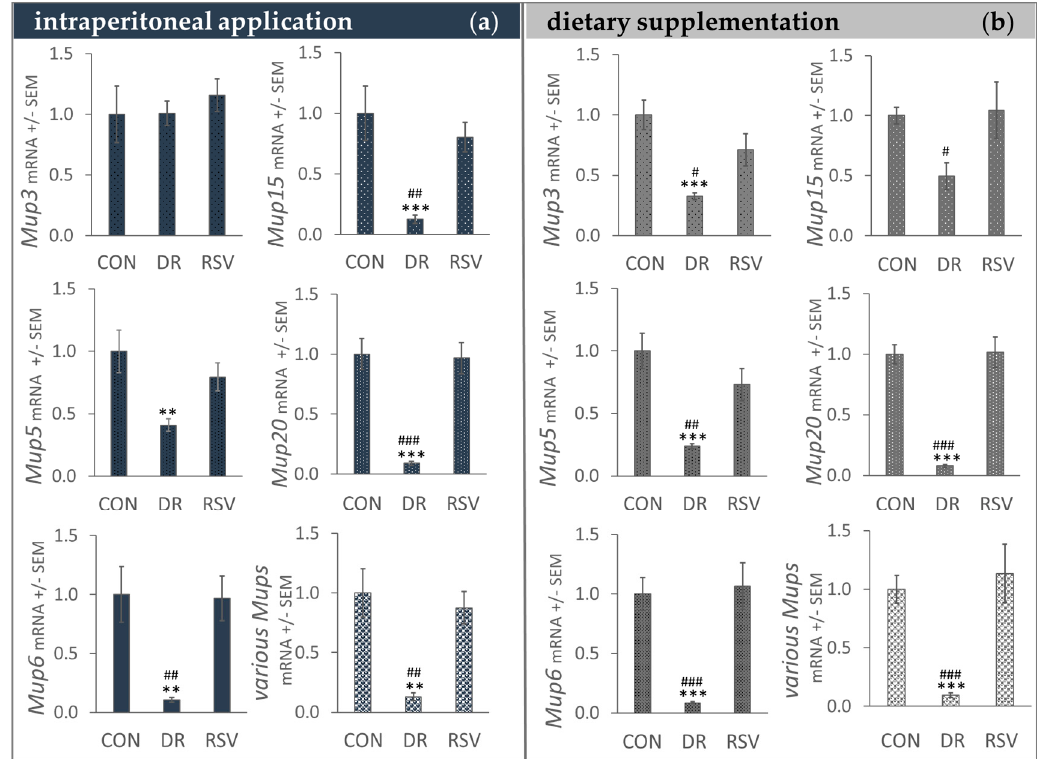
Figure 2. Real-time RT PCR results for gene coding for mouse urinary protein ( Mup ) mRNA levels in livers of mice injected intraperitoneally ( a ) or fed ( b ) with resveratrol (RSV) compared to ad-libitum control mice (CON) and mice under dietary restriction (DR). mRNA levels were normalized to 18S ribosomal RNA and related to CON which was set to be 1. Data is shown as means +/ − SEM. ** p < 0.01, *** p < 0.001 compared to CON; # p < 0.05, ## p < 0.01, ### p < 0.001 compared to RSV (Tukey).